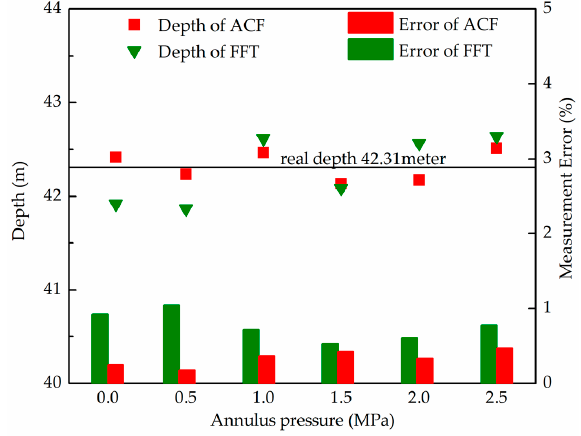
Figure 12. Comparison of liquid level determination between FFT and ACF under different annulus pressures.